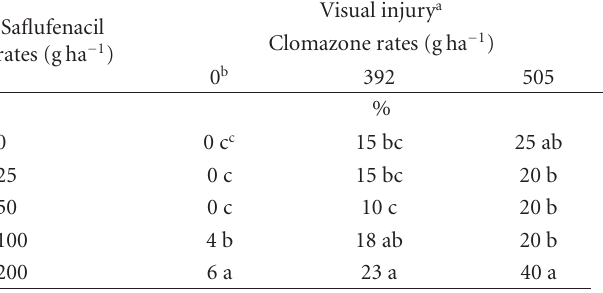
Table 3: Rice ( Oryza sativa L.) visible injury at 22 DAE in response to saflufenacil and clomazone applied preemergence. Data represent an interaction between rates of saflufenacil and clomazone in